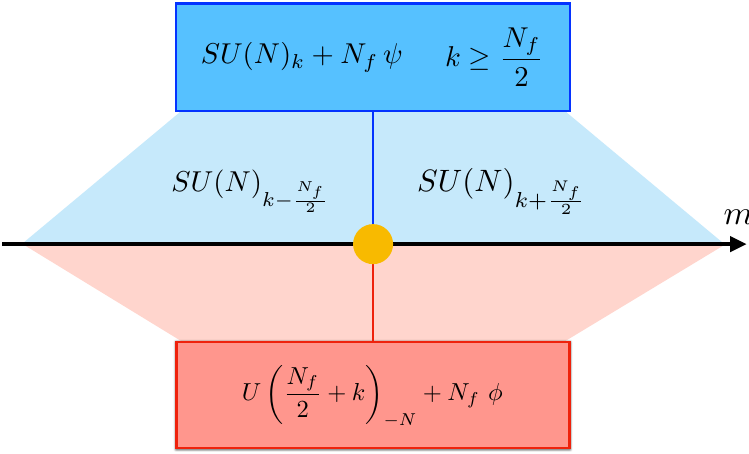
N f . The two 3 (shown in blue) when k (cid:21) 2